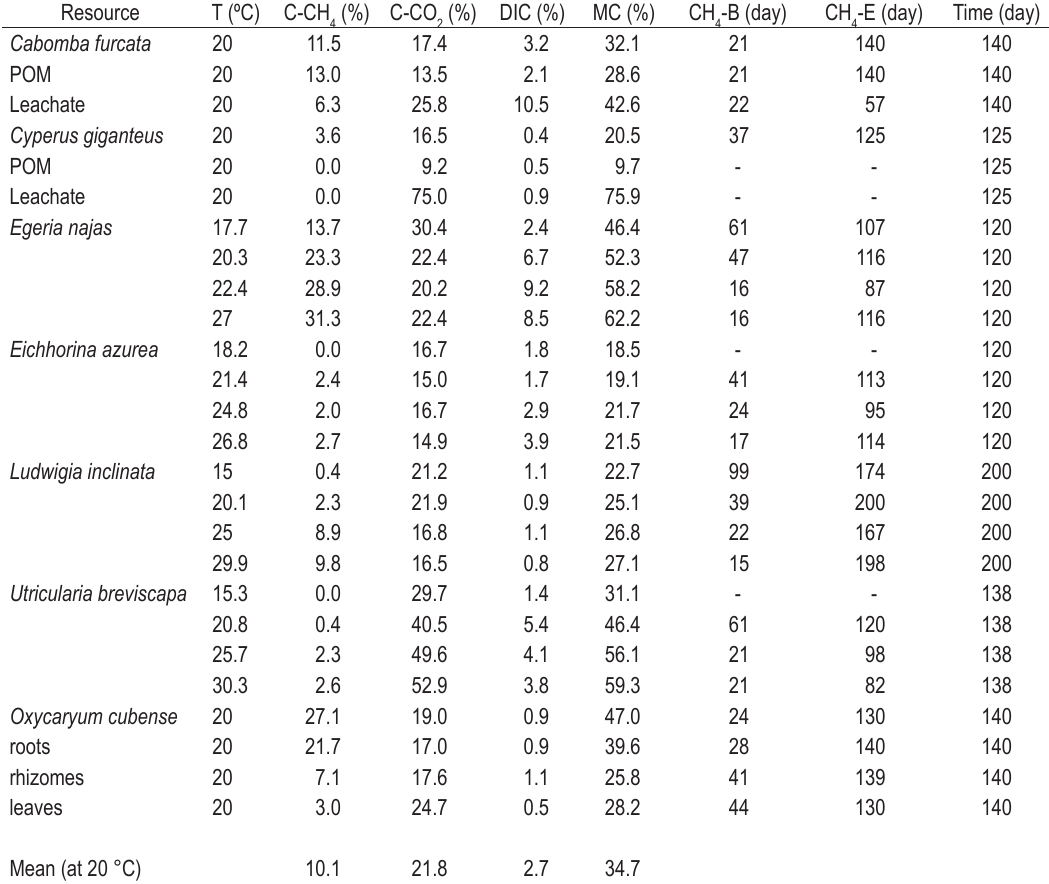
Table 2. Parameters related with methane formation during decay of different resources linked with aquatic mac- rophytes. Where: T: temperature of incubation; C-CH : the yield of methane (on carbon basis); DIC: dissolved 4 inorganic carbon; C-CO : the yield of dioxide of carbon (on carbon basis); MC: mineralization yield (on carbon 2 basis); CH -B and CH -E: days of beginning and end of methane formation, respectively; Time = accumulate days 4 4 of